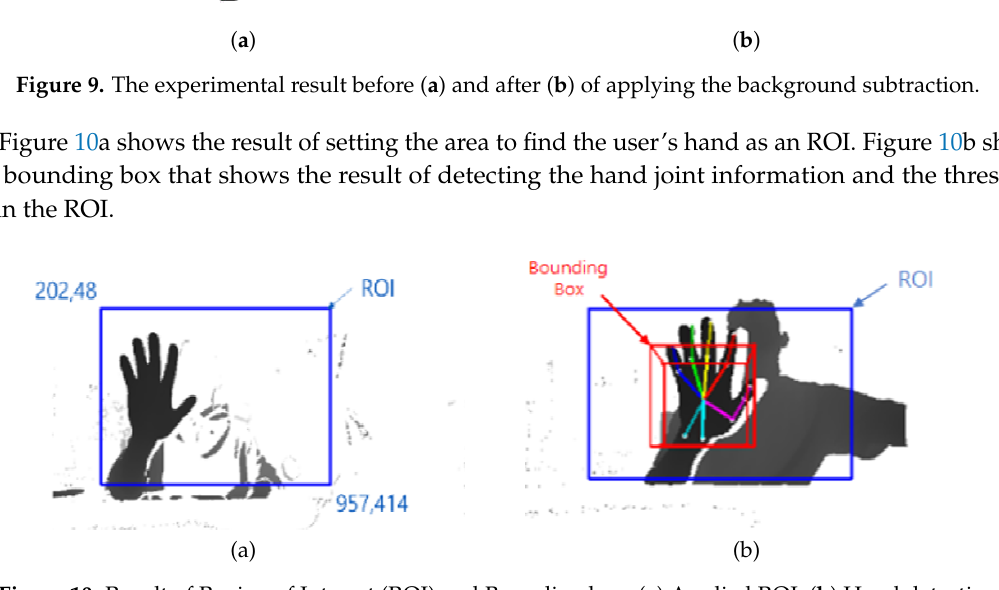
Figure 10. Result of Region of Interest (ROI) and Bounding box. ( a ) Applied ROI; ( b ) Hand detection with 14 joint points and Bounding box.